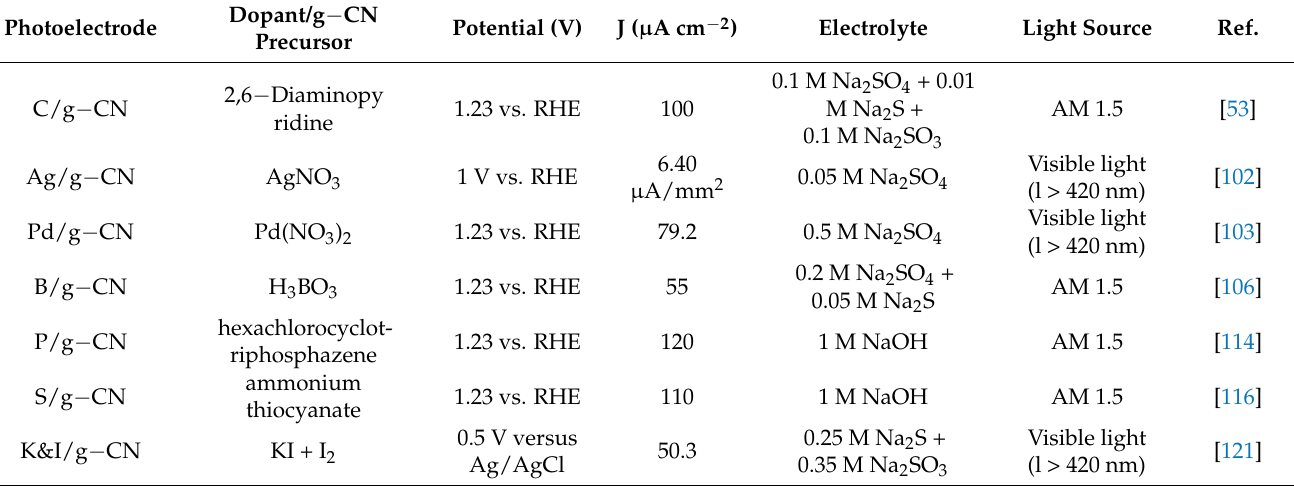
Table 3. Representative summary of the PEC activity enhancement of g − CN-based